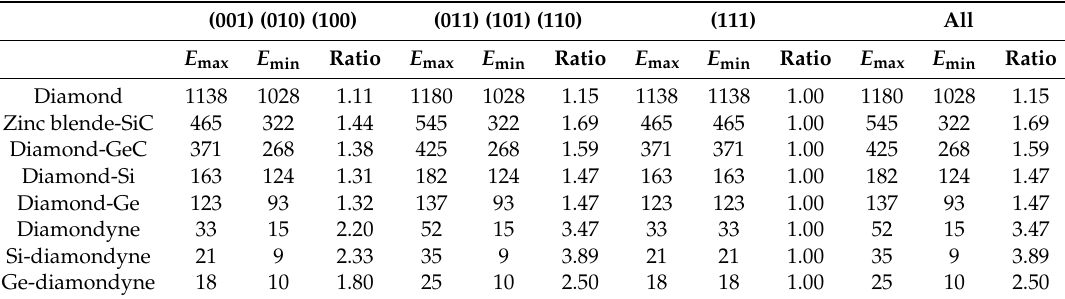
Figure 5. ( a ) The maximum values and the minimum values of Young’s modulus; ( b ) the maximum values and the minimum value of shear modulus; and ( c ) the E max / E min and G max / G min ratios of diamond, zinc blende-SiC, diamond-GeC, diamond-Si, diamond-Ge, diamondyne, Si-diamondyne and Ge-diamondyne. Table 3. The maximum values and the minimum values of Young’s modulus (in GPa) and E max / E min in primary planes for diamond, zinc blende-SiC, diamond-GeC, diamond-Si, diamond-Ge, diamondyne, Si-diamondyne and Ge-diamondyne.